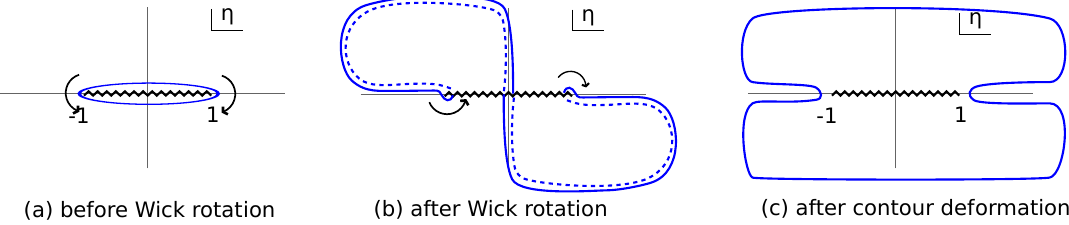
Figure 5 . (a) after the replacement (C.7), the contour for (cid:17) circles the branch cut of the B J function. The arrows indicate the direction in which the contour passes the branch points at (cid:17) = (cid:6) 1 as we increase (cid:28) (cid:0) (cid:28) 0 . After Wick rotation we end up deforming the contour as in (b). The dashed parts of the contour are on the second sheet. Note that the arcs at in(cid:12)nity are shown at (cid:12)nite radius for clarity. The arrows indicate the direction in which the contour passes the branch points as we increase v (cid:0) v 0 , with u (cid:0) u 0 (cid:12)xed. Finally, when we deform the contour over v; v 0 we pull the dashed portions of the contour on the second sheet back through the cut to the (cid:12)rst sheet, giving the contour in (c). We further drop the arcs at in(cid:12)nity, so that we have just the integrals along the real axes, picking up discontinuities across branch cuts from the four point